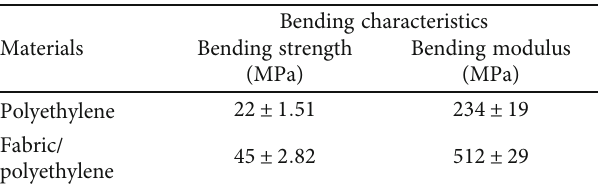
Table 2: Bending characteristics of polyethylene (PE) and fabric/ PE composites.